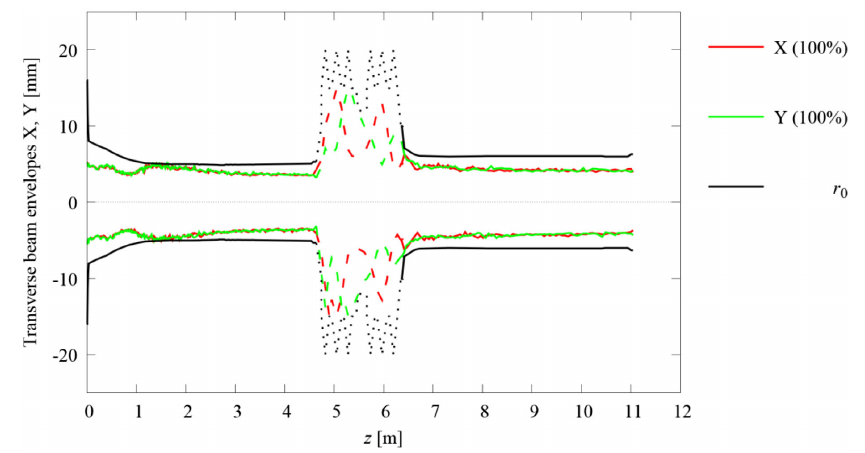
FIG. 12. Transverse beam envelopes for all particles along the linac (the solid lines are for the RFQs and the dashed lines are for the MEBT section,